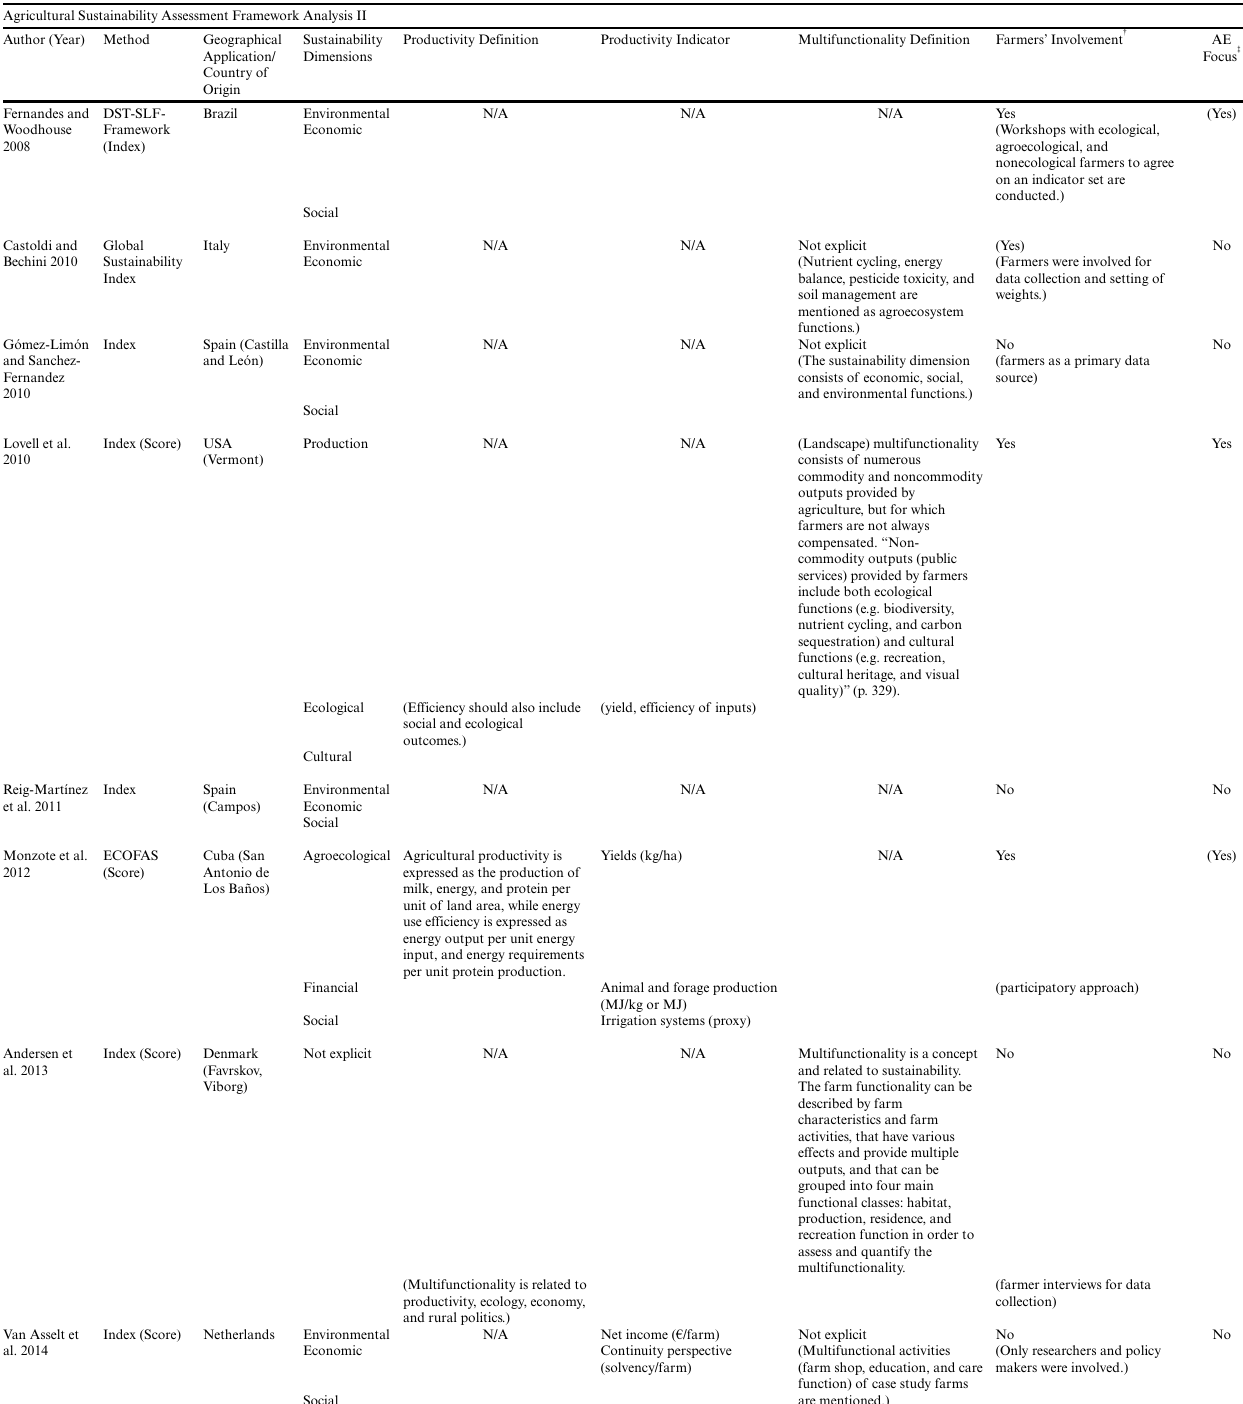
Table 4 . Framework analysis II. Evaluation criteria of the analysis of the integrated indicator-based agricultural sustainability assessment frameworks at the farm level that were described in the literature were the assessment methodology, the geographical scope, the sustainability dimensions, the multifunctionality and productivity definition plus corresponding productivity indicators, the focus on agroecology (i.e., AE focus), and the involvement of the farmers in the development process of the